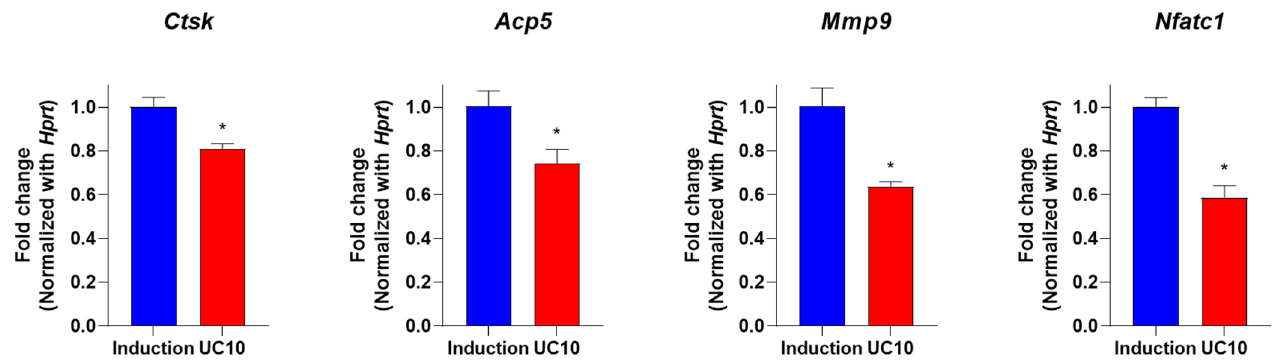
Figure 6. Inhibitory effects of UC extract on osteoclast differentiation-related genes in primary osteoclasts. Mouse primary monocytes were co-incubated with an osteoclast induction medium and UC 5:5 extract (10 µ g/mL). After 5 days, the expression levels of mouse Ctsk , Acp5 , Mmp9 and Nfatc1 were evaluated by qRT-PCR. The samples were determined in triplicate. UC, Ulmus davidiana (UD) and Cornus officinalis (CO) 5:5 ratio treatment; * p < 0.05 vs. induction (Student’s t -test).